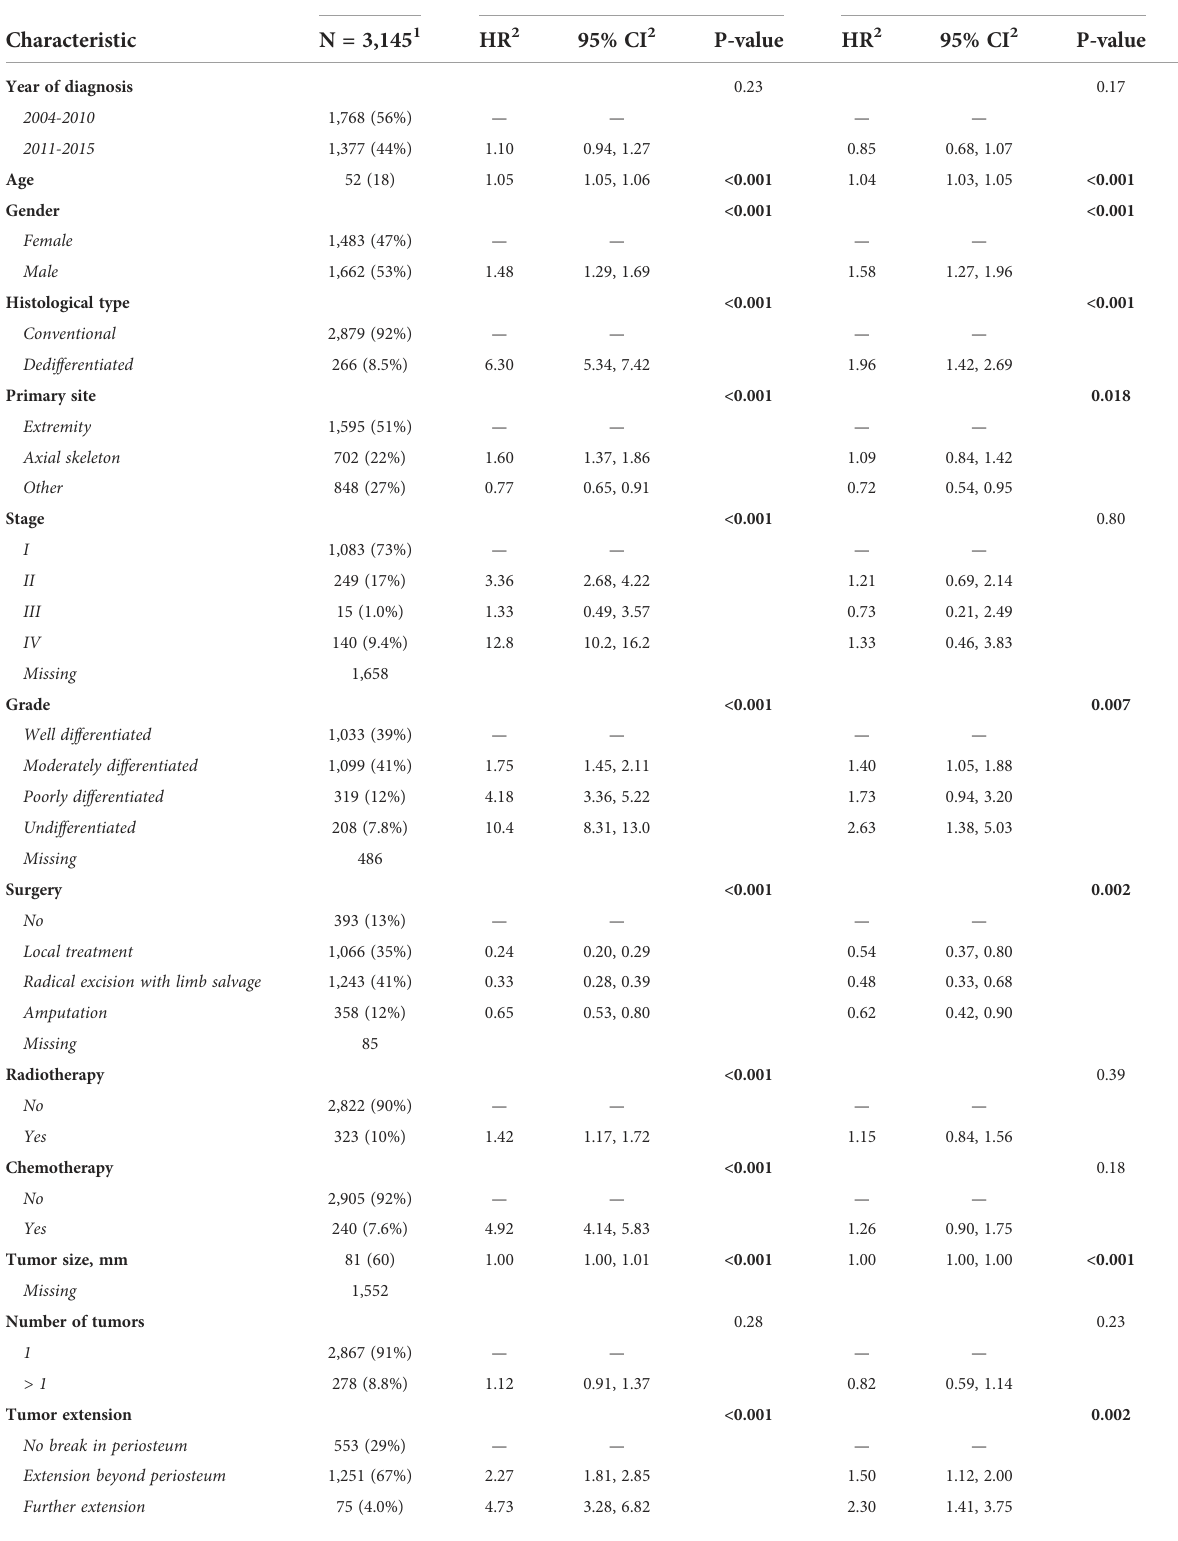
TABLE 1 Patient demographic, disease, treatment characteristics, and Cox regression